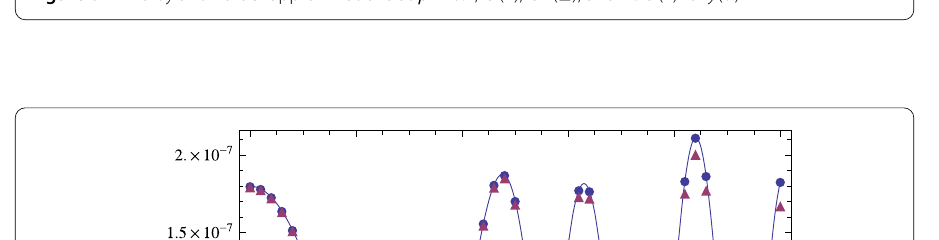
Figure 6 ARES by sixth-order approximations at β = 0.7, C ( • ), CF ( (cid:2) ), and ABC (–) for y ( τ )